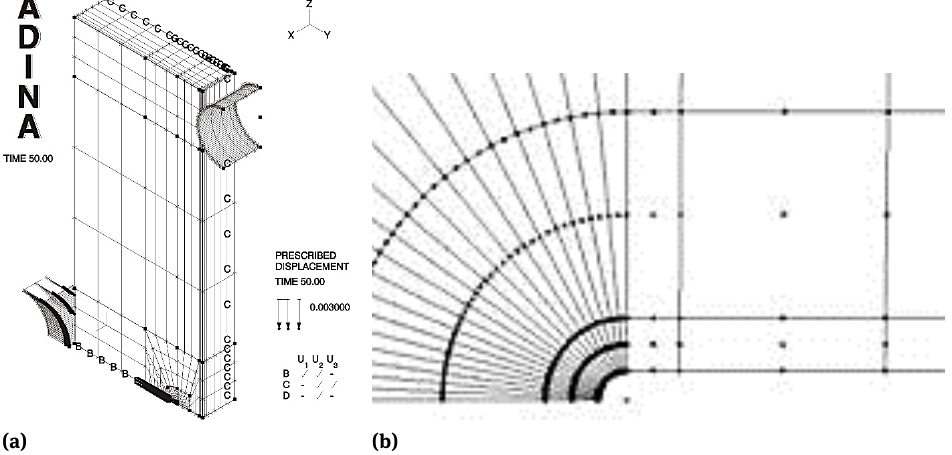
Figure 5: Exemplary numerical model of the SEN(B) specimen used in the FEM 3D calculations; b) A fragment of the mesh around the